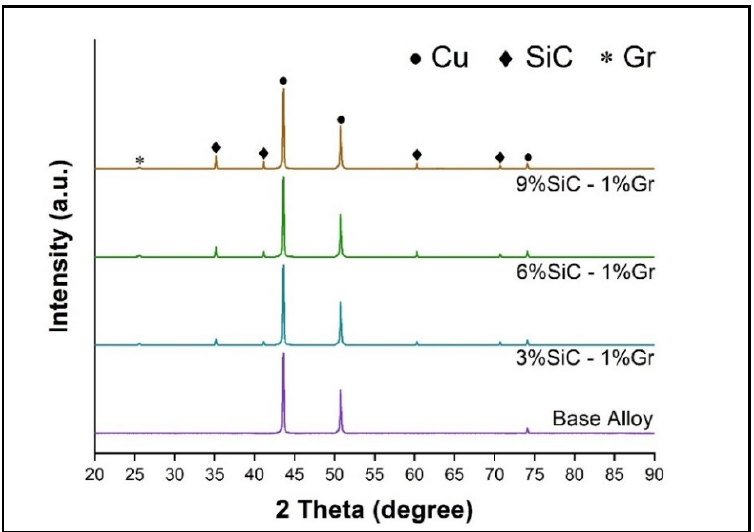
Figure 7. XRD phase analysis of Cu alloy and Cu-(3, 6, 9) wt.% SiC-Gr hybrid composites.